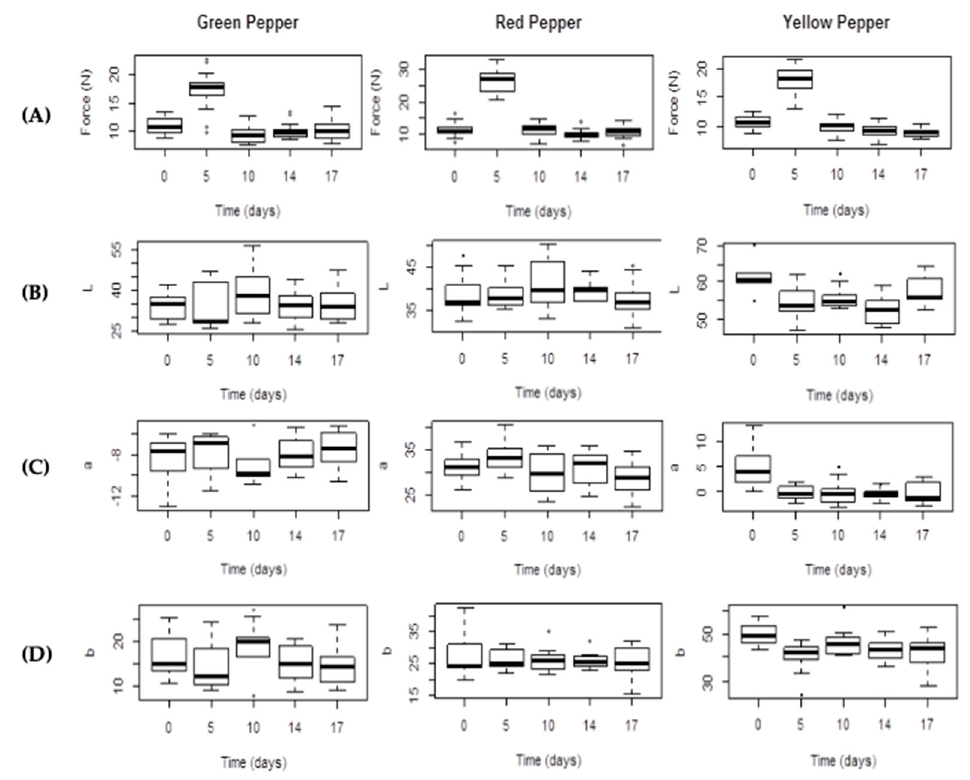
Figure 3. ( A ) Instrumental firmness; ( B – D ) L *, a * and b * color values of fresh-cut bell peppers (green pepper; red pepper; yellow pepper) stored under an initial MAP condition of 10% O 2 and 45% CO 2 throughout 17 days at 5 °C.